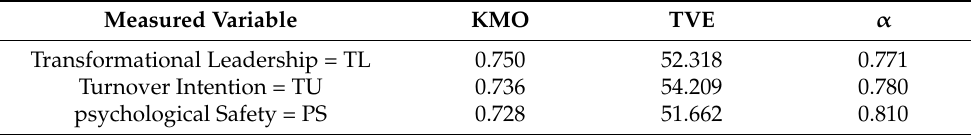
Table A2. KMO, Total Variance Explained and Cronbach